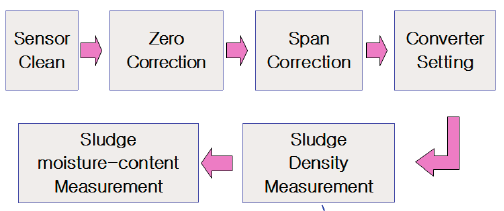
Figure 12. Experimental procedure for the pilot plant.